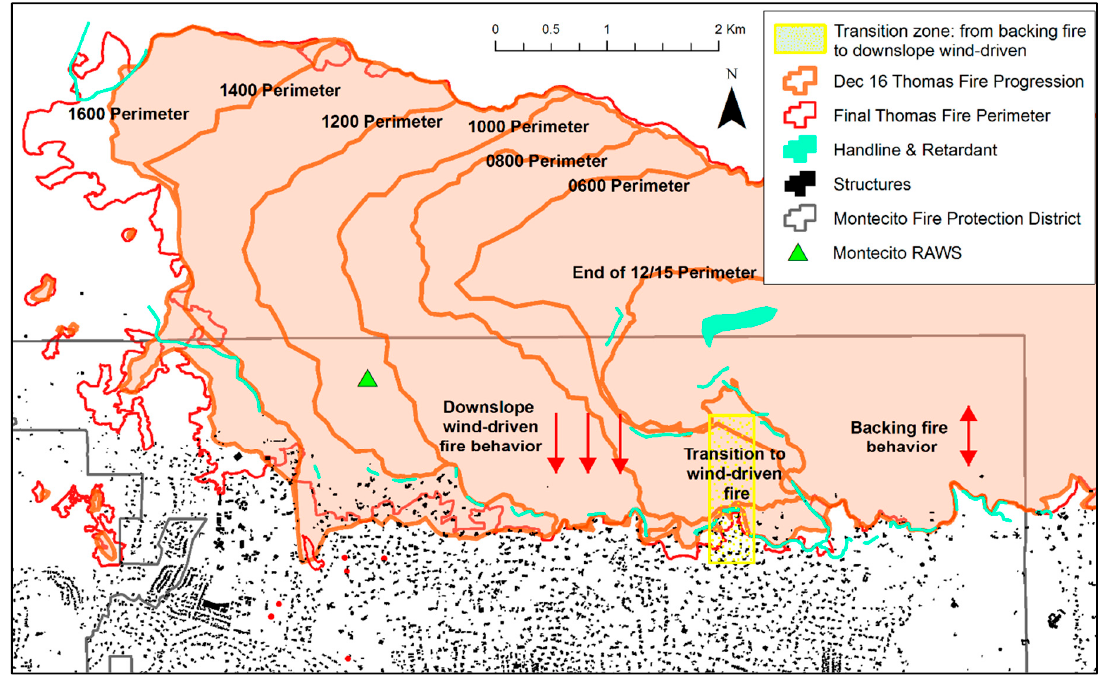
Figure 7. Thomas Fire progression on 16 December 2017, in the vicinity of Montecito, where the fire primarily moved westward, and was pushed downhill by Sundowner winds. (Adapted from [47]).